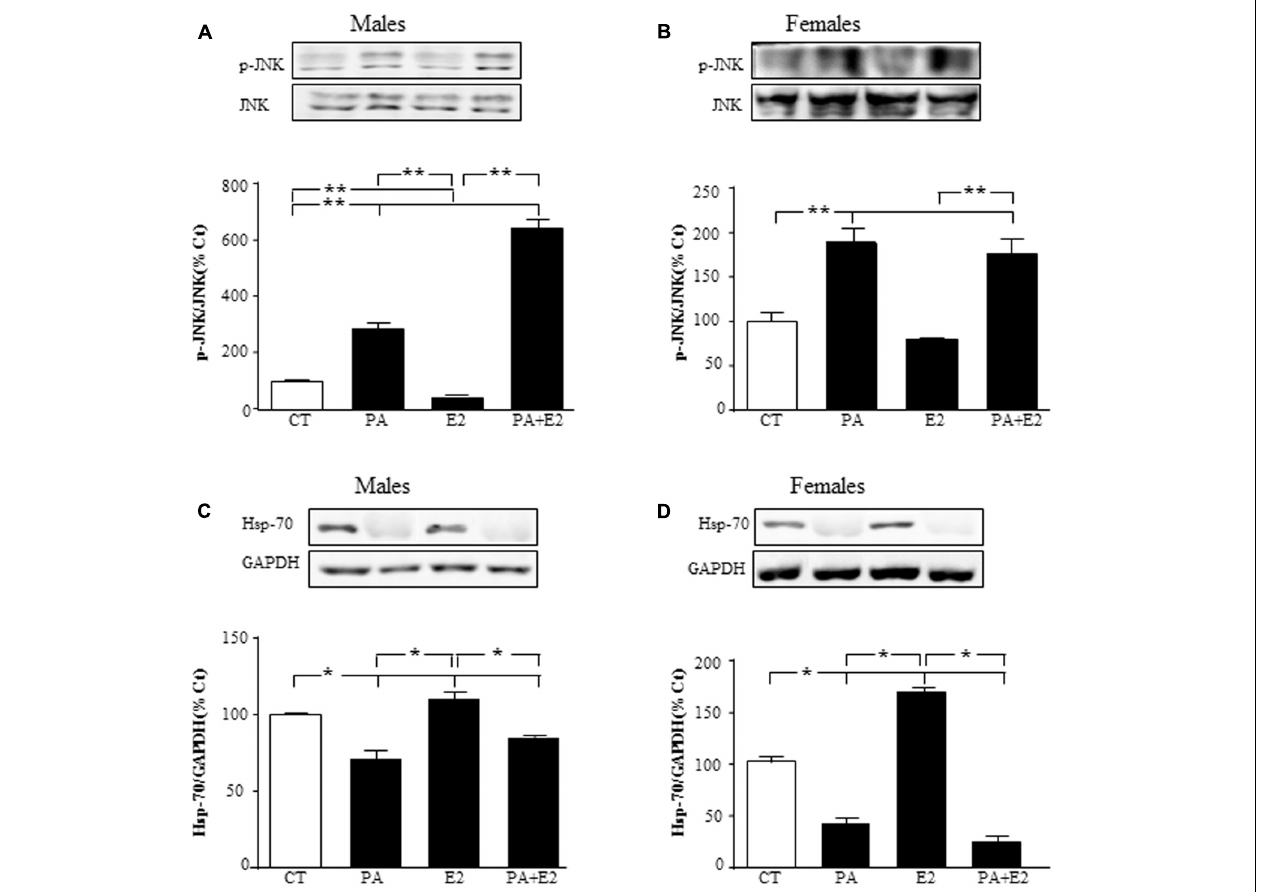
FIGURE 6 | Effects of PA and 17 β E2 on c-Jun N-terminal kinase (JNK) and heat shock protein 70 (Hsp70). Astrocyte cultures were treated with PA (0.5 mM), E2 (10 − 10 M) or the combination of both. Immunoblots were probed with antibodies toward phosphorylated-(p-JNK) and JNK in males (A) , and females (B) ; and Hsp70 in males (C) ; and females (D) . The average of three independent assays performed in duplicate is shown. Statistical significance: ∗ p < 0.05 and ∗∗ p <